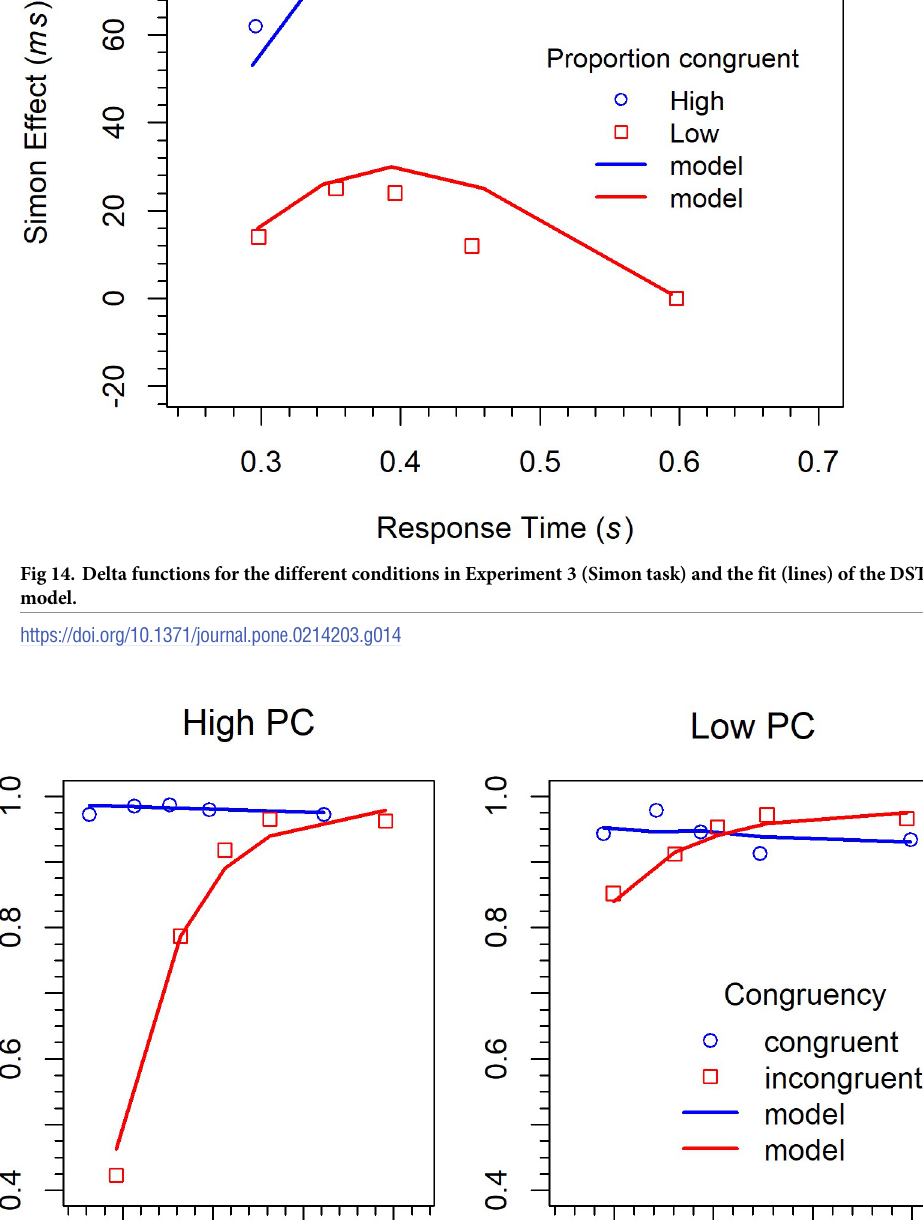
PLOS ONE | https://doi.org/10.1371/journal.pone.0214203 March 28,